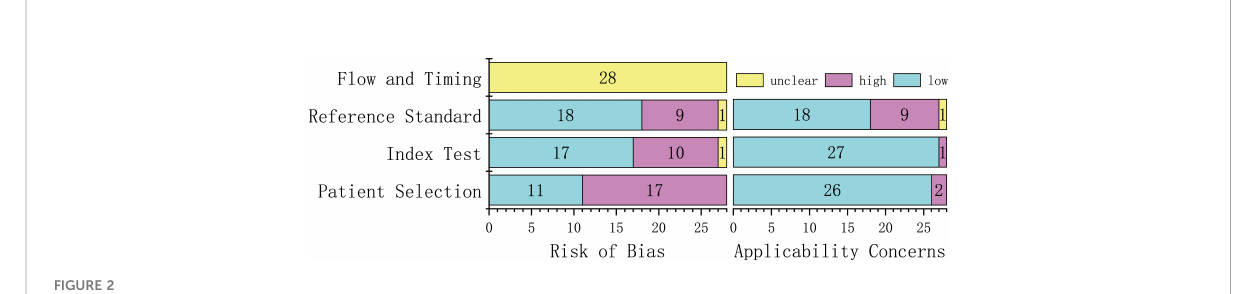
FIGURE 2 The risk of bias and concerns regarding applicability of 28 included